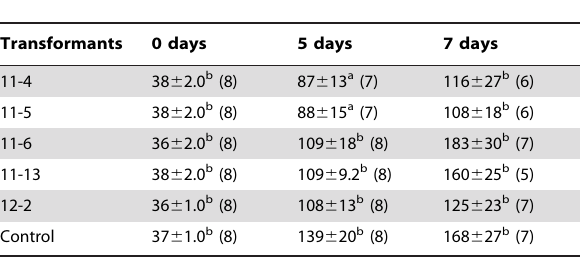
Values represent mean larval weight 6 SE (mg). Means followed by the same superscript within columns are not significantly different ( P , 0.05) by one-way ANOVA test. Number in parenthesis indicates the number of living larvae out of 8 that were